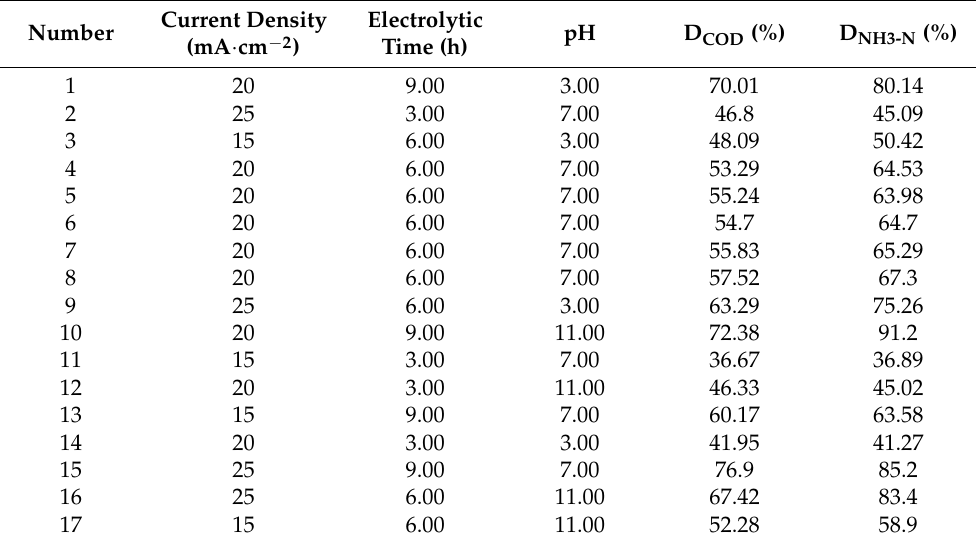
Table 3. Design matrix and the experimental responses.